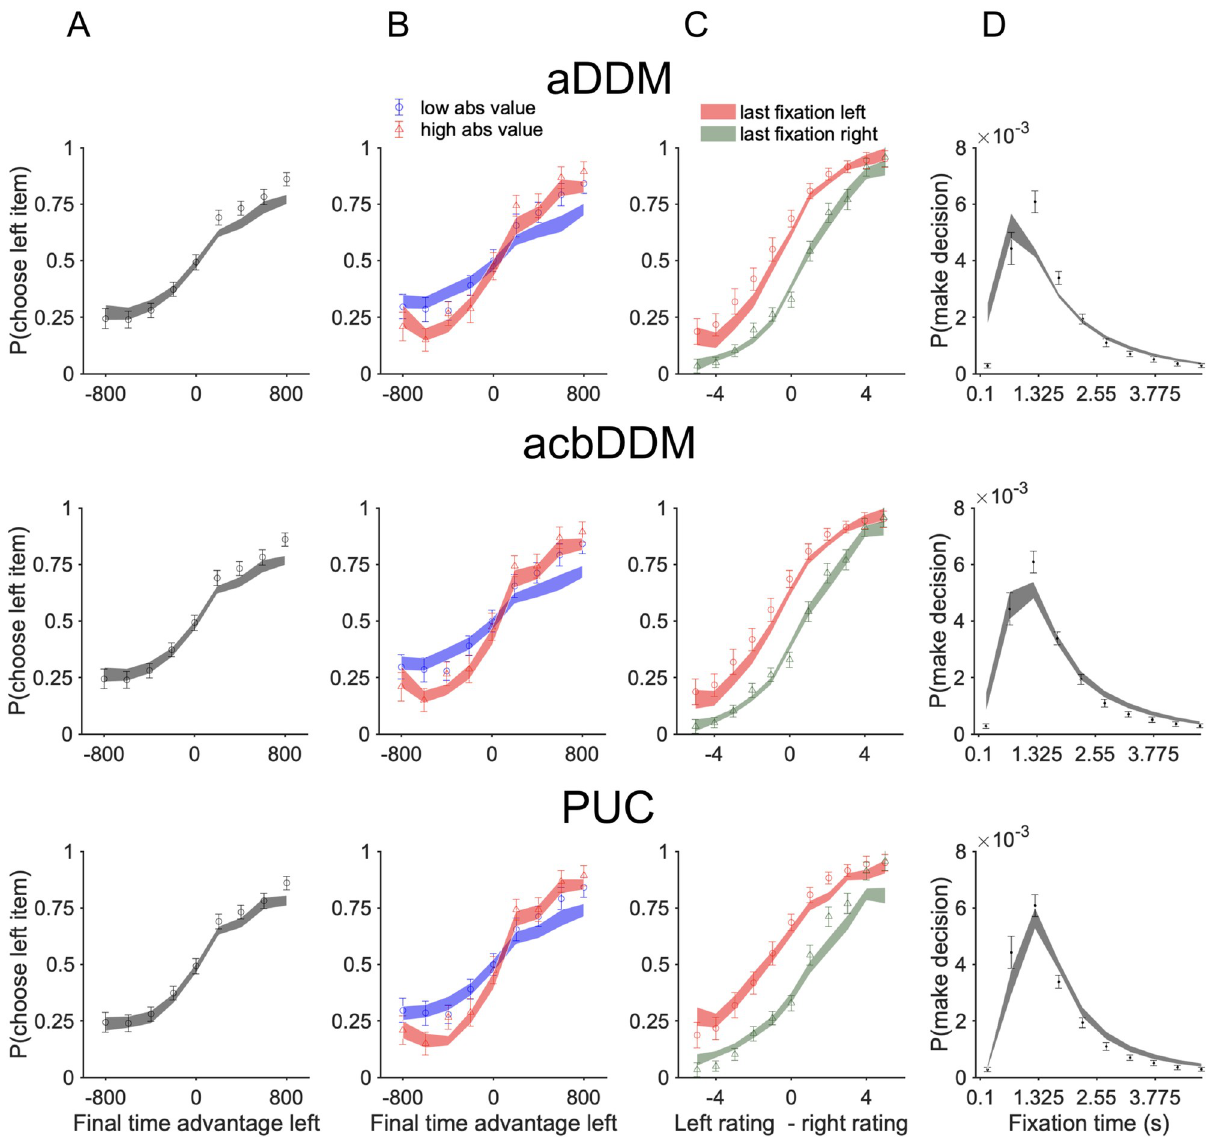
Fig 3. Fits of the aDDM, the acbDDM, and the PUC model to summary statistics of the data. (A) When the total fixation time advantage of an item increases, that item is chosen more often. (B) Same as A but conditioned on item rating. Both models predicted that when the absolute values of both items are higher (i.e. both are more preferred items), the fixation modulation effect is larger, which trend is less significant in the empirical data. (C) Besides total fixation duration, the last fixation also biases the choice. (D) Distribution of total fixation time. The aDDM fits we obtained differ from those in [1] not only because of differences in parameter estimation methods (see Model fitting and model comparison—Differences from Krajbich et al. (2010) ), but also because of a difference in trial aggregation (see Results—PUC versus aDDM